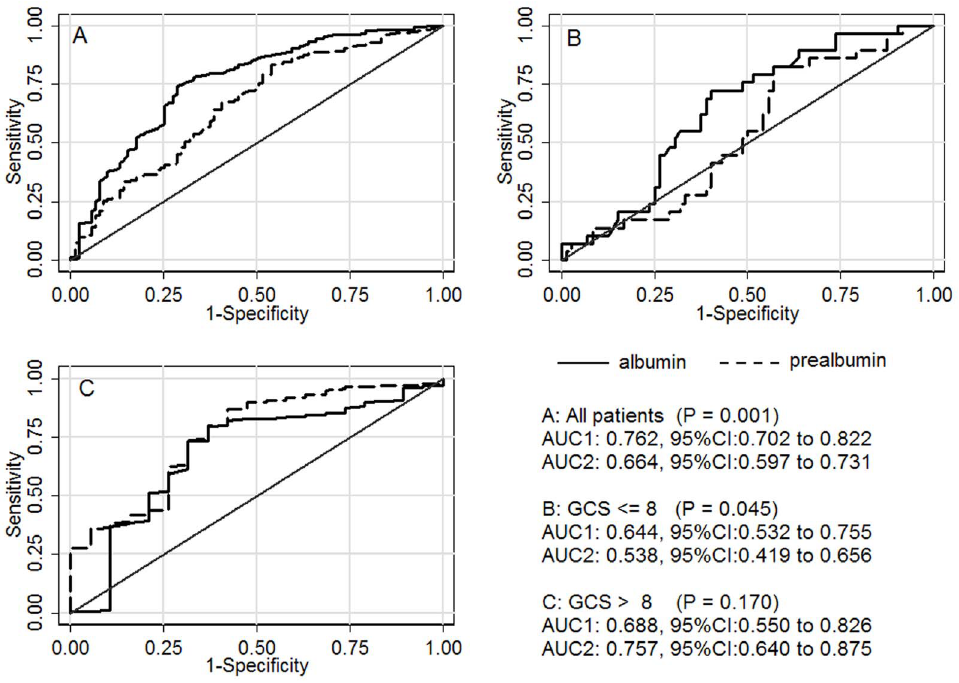
Figure 4. ROC curve analyses of different groups of TBI. AUC1 and AUC2 are on behalf of the areas under the ROC curves of serum albumin and prealbumin, respectively. In all patients and subgroup of GCS # 8, the AUCs of serum albumin were significantly higher than those of prealbumin ( P =0.001 and P =0.045, respectively), while in the subgroup of GCS . 8, no significant differences of AUCs were observed ( P =0.170). Furthermore, the AUCs of serum albumin were statistically significant in both subgroups ( P , 0.05), while prealbumin showed no predictive value in the subgroup of GCS # 8 (AUC=0.538, 95%CI: 0.419 to 0.656, P . 0.05).